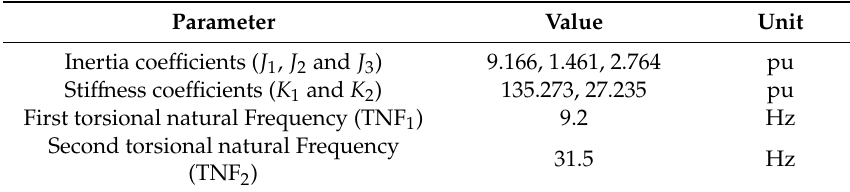
Table 2. TG units’ mechanical parameters.